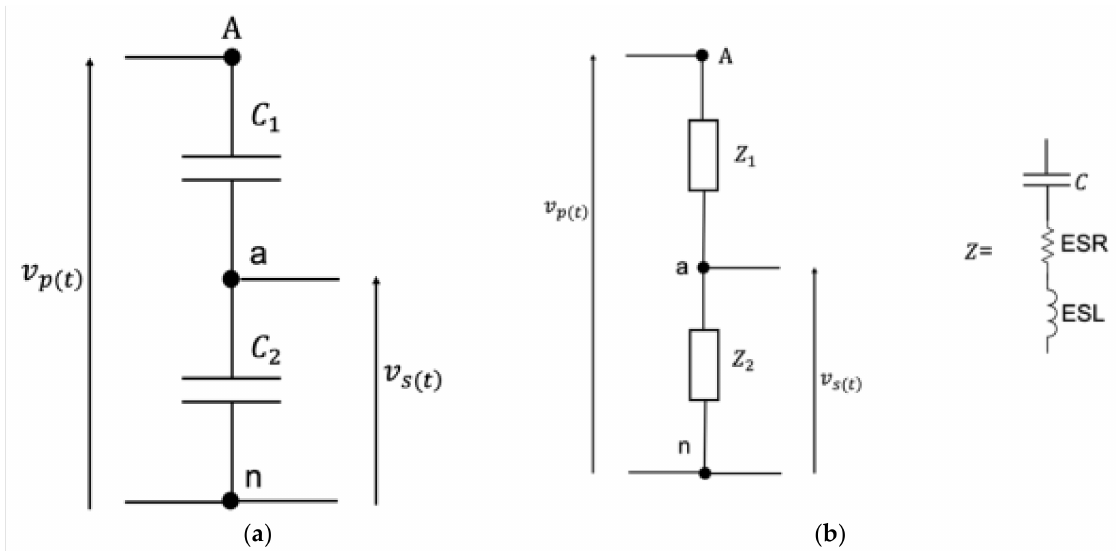
Figure 1. ( a ) Ideal representation of a capacitive divider. ( b ) Real representation of a capacitive divider, which is made of